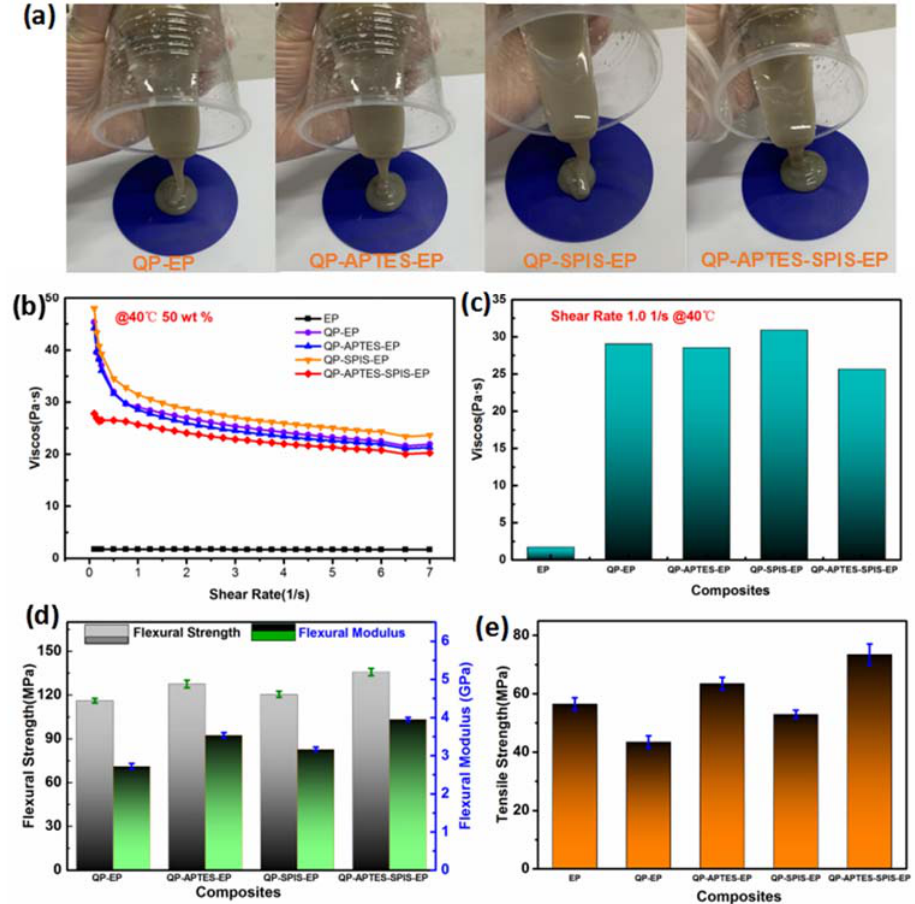
Figure 7. Mechanical properties of the neat EP and their composites. ( a ) Photographs of the flow properties of epoxy composites ( b ) Relationship between viscosity and shear rate. ( c ) Viscosity at a shear rate of 1.0 1/s. ( d ) Flexural strength and modulus. ( e ) Tensile strength.